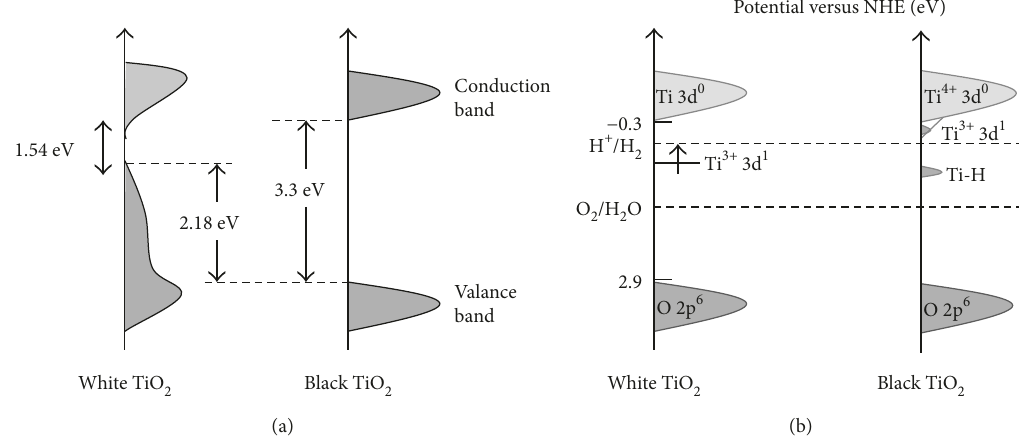
Figure 3: (a) Schematic illustration of the DOS of black and white TiO American Association for the Advancement of Science. (b) Schematic illustration of the DOS of TiO nanocrystals. Reprinted with permission from [33]. Copyright (2013)